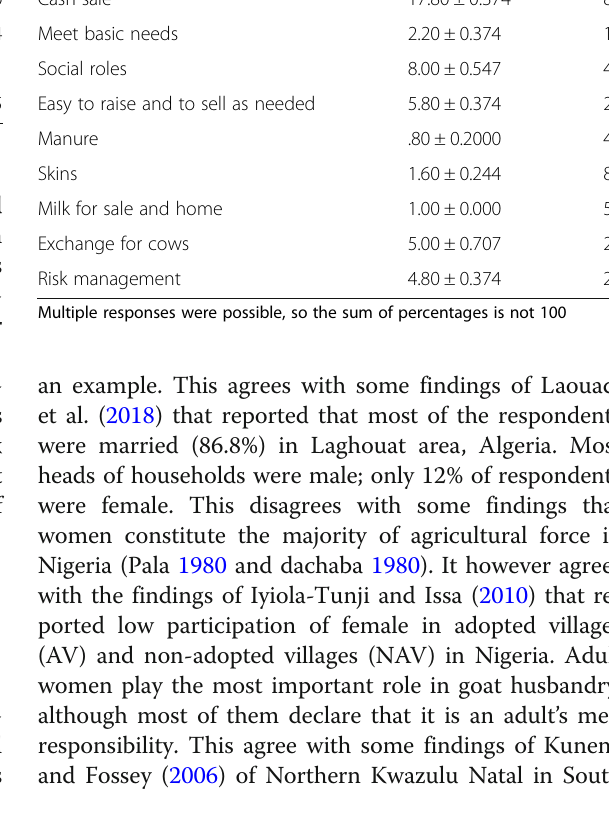
Table 5 Goat management under different villages in rural areas of the Nile Delta in Egypt